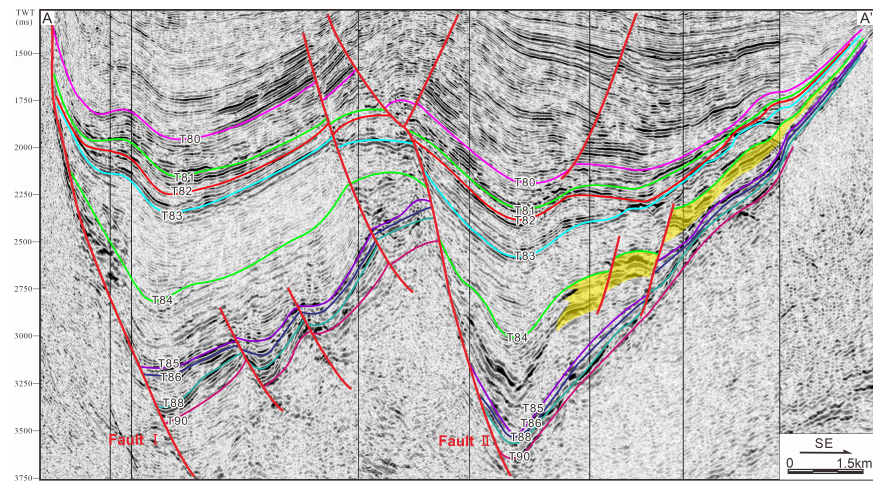
Figure 3. Seismic section (northwest to southeast) across the Weixinan sag showing the sequence boundaries, stratigraphic units and major faults. The targeted Mbr2 of the Liushagang Fm. is from T85 to T84 reflectance surface. The light yellow color in the figure refers to the beach-bar